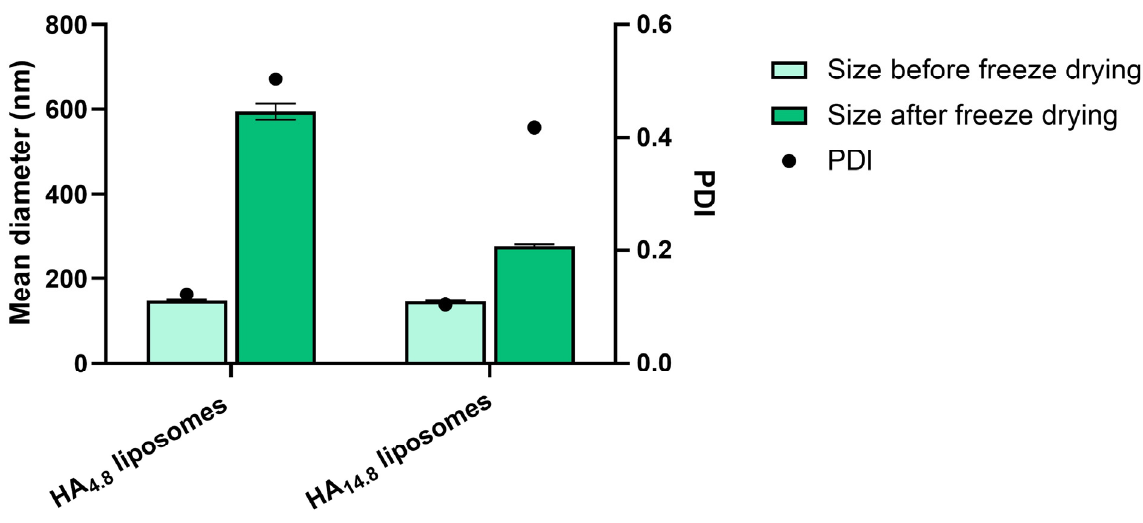
Figure 5. Particle hydrodynamic diameter and PDI of liposomes before and after freeze-drying in the presence of free HA ( n = 3).